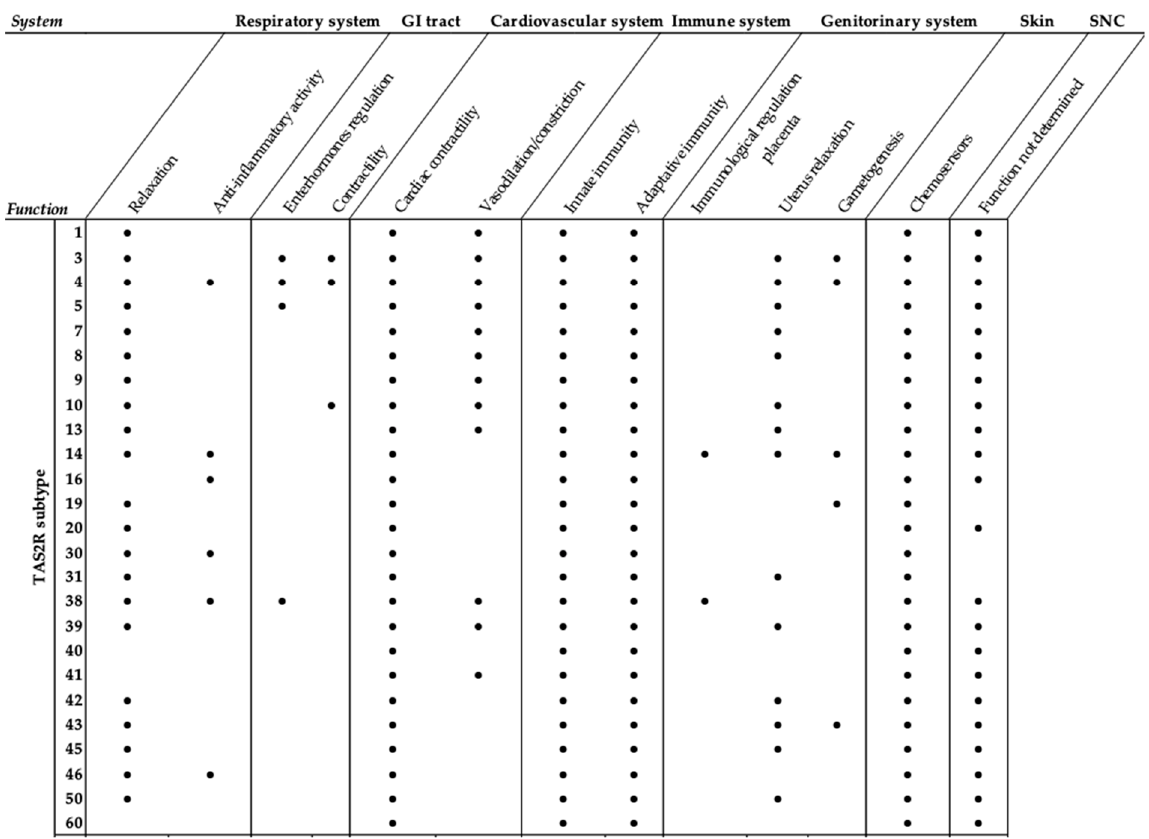
Figure 1. TAS2R expression and mediated functions in human tissues: respiratory system [14,19,26,27]; gastro-intestinal tract [20,31,32]; cardiovascular system [21,22,24,33,34]; immune system [26,35–39]; genitourinary system [29,30,40–44]; skin [37,45,46]; SNC [47,48].